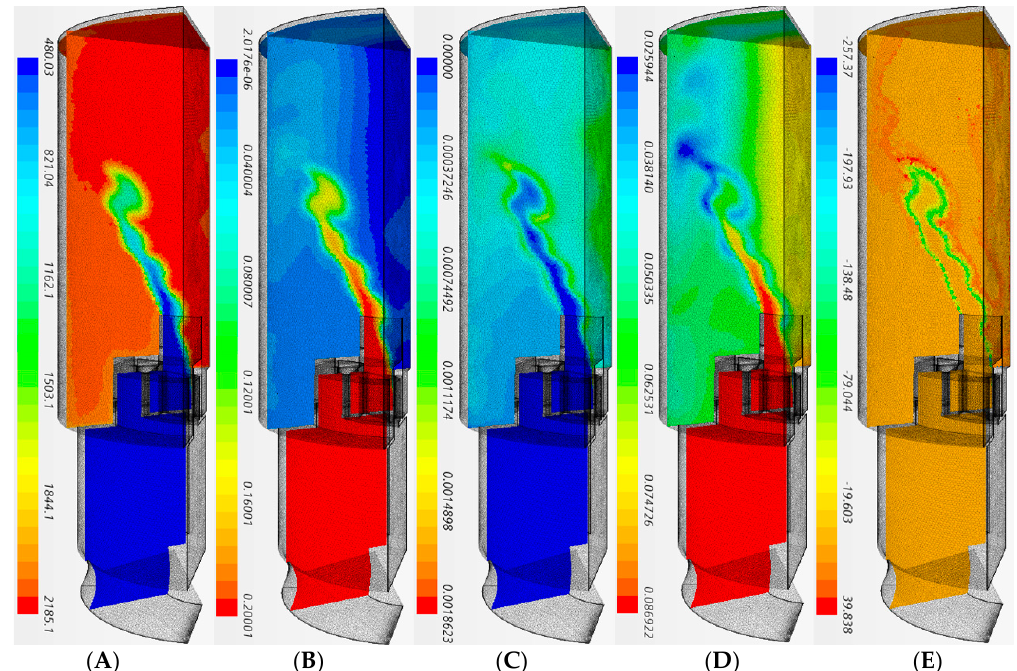
Figure 8. ( A ) Temperature (K); ( B ) ammonia concentration (mol%); ( C ) NO concentration (mol%); ( D ) hydrogen concentration (mol%); ( E ) hydrogen rate of production (kg/m 3 ·s). Operating conditions: 900 kPa, 500 K inlet temperature, 1800 K quartz tube.